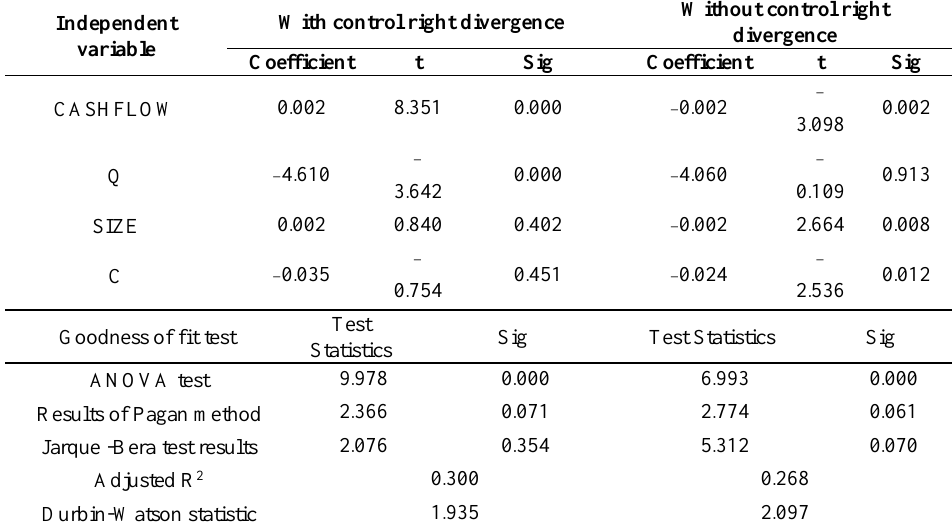
Table 2. The role of the divergence of shareholder controlling right in increment of the cash flow sensitivity of cash to cash